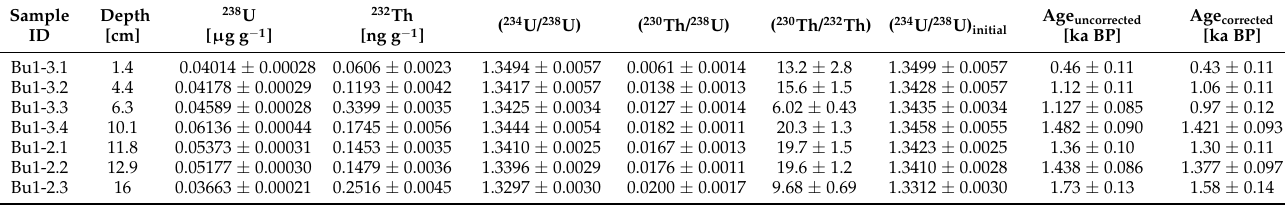
Table 1. U and Th isotopic compositions as well as uncorrected and corrected 230 Th/U-ages for Bu1 (Bunker Cave). Errors are 2 σ analytical uncertainties, and activity ratios are indicated by parentheses. All ages refer to BP (BP = before present, AD